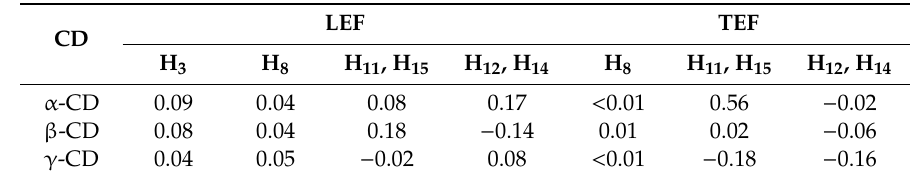
Table 1. Chemical shift changes ( ∆ c δ , ppm *) of protons of leflunomide (LEF) and teriflunomide (TEF) induced by complex formation with cyclodextrins (CDs) at 298.15 K **.